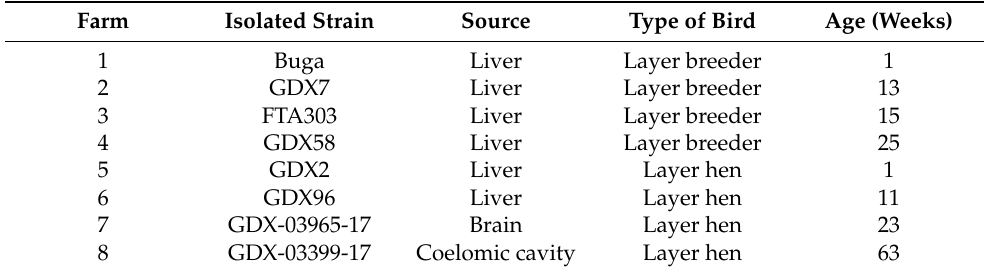
Table 1. Strains isolated in this study.